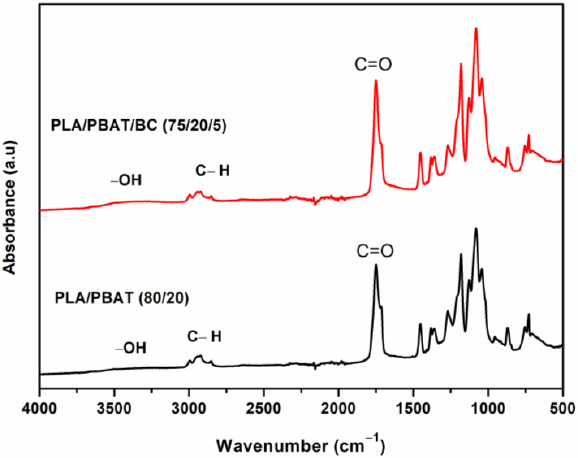
Figure 6. FTIR of PLA/PBAT blend and PLA/PBAT/BC (75/20/5)